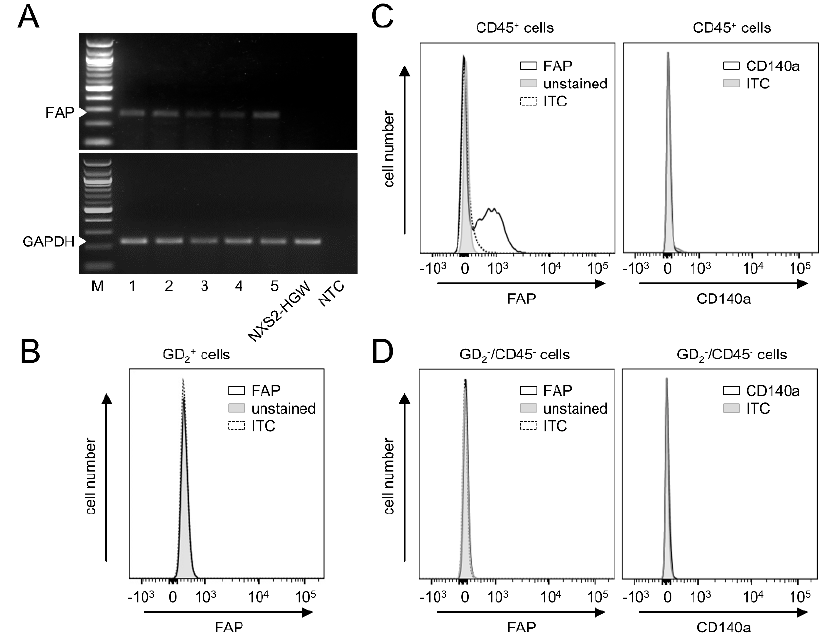
Figure 4. Analysis of FAP and CD140a expression in murine tumor tissue. ( A ) Representative images of the RT-PCR analysis of FAP mRNA levels (PCR product size: 268 bp) in five tumor tissue samples (1–5) and by the murine tumor cells NXS2-HGW that were used for tumor cell implantation. GAPDH (PCR product size: 238 bp) served as an internal control. M: marker, NTC: no template control. ( B ) A representative histogram of the flow cytometry analysis of FAP and CD140a abundance in the GD 2 - and CD45 double-negative cells within primary tumor tissue. Samples were collected when tumors reached a size of 750 mm 3 , followed by enzymatic digestion to obtain a single-cell solution. Samples were then stained with rabbit anti-mouse anti-FAP IgG and PE-labeled anti-rabbit IgG Ab, which served as primary and secondary Ab and FITC-labeled anti-mouse CD140a Ab, respectively (black curve), or appropriate ITC (black dashed curve). Unstained cells served as negative control (unstained; grey-filled curve). ( C ) A representative histogram of the flow cytometry analysis of FAP and CD140a abundance in the CD45-positive cells detected in tumor tissue. ( D ) A representative histogram of the flow cytometry analysis of FAP levels in NXS2-HGW cells that served for induction of primary tumors. Full gel images can be found at Supplementary Materials.